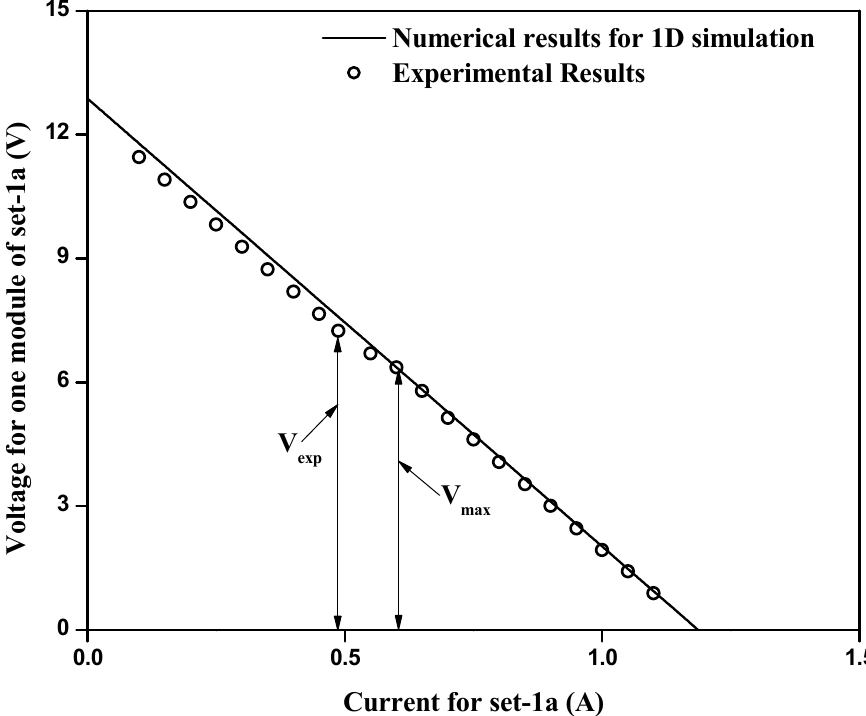
− 3.368 Figures 8 and 9 depict the thermoelectric generator polarization curve and power curve obtained by activating the electronic load (R ex ) after the establishment of thermal equilibrium across the generators for one module of set ‐ 1a. The polarization and power curves were calculated based on the experimental and numerical data. The numerical re ‐ sults show a linear relation in the polarization curve, whereas the experimental results are not perfectly linear. This may be due to the fact that the experiments were conducted in real ‐ time conditions in an industrial setting. Small changes in atmospheric conditions dur ‐ ing the experiments may cause variations in radiant and convective heat transfer to the absorber plate surface from the billet surface, which also leads to fluctuations in the tem ‐ perature difference across the TEG. This may be the reason for the variations in the exper ‐ imental results. The maximum variation in the voltage obtained for the experimental anal ‐ ysis was found to be 4.4% of the numerical results. Figure 9 shows the variation in the